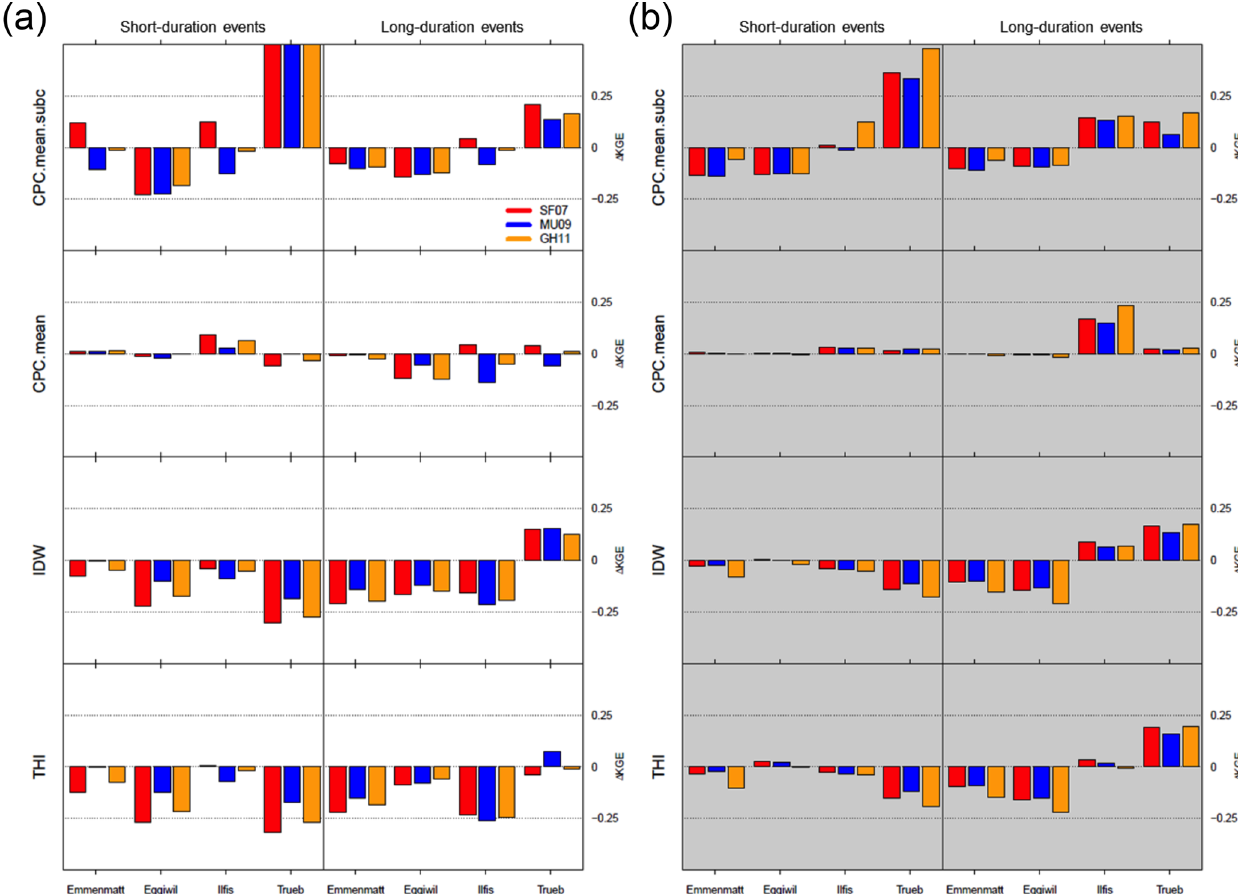
Figure 10. Averaged KGE deviations from the benchmark modelling chain (i.e. driven by Combiprecip data) obtained with the bottom- up (a) and top-down (b) configurations. Each block corresponds to a specific modelling chain based on the rainfall data reported on the left (CPC = Combiprecip; IDW = inverse distance weighting; THI = Thiessen polygons), whereas the displayed event types are reported at the top. The bars represent the average performance difference obtained from Monte Carlo runs for each of the four study areas, whilst the colour of the bars represent the different mapping approaches. Overall, the performance deviations were higher for the bottom-up than for the top-down